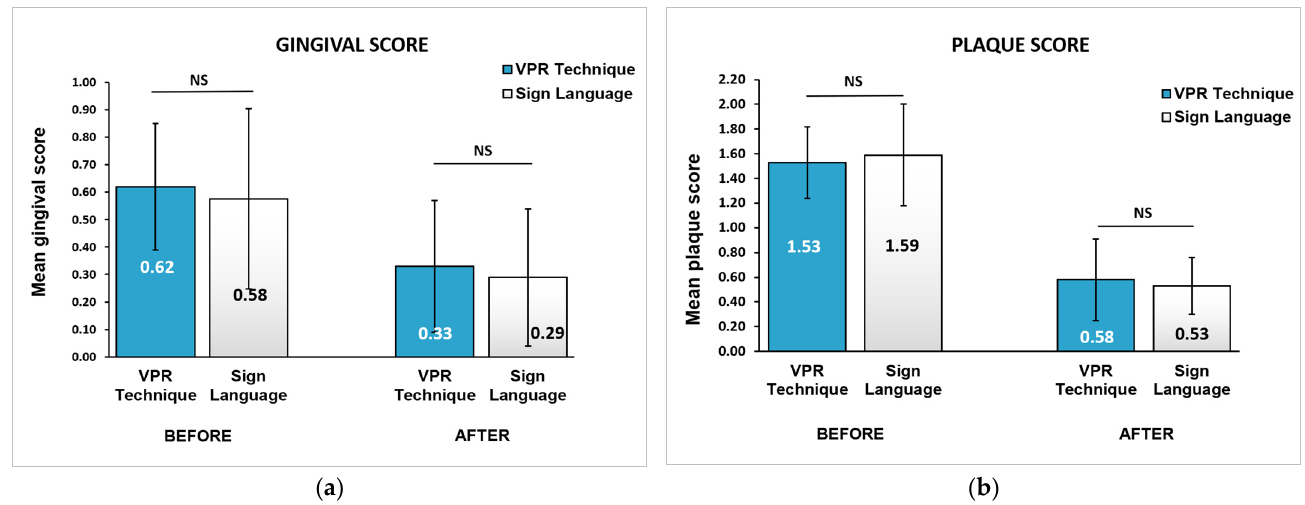
Figure 2. Comparison of ( a ) mean gingival score and ( b ) mean plaque score in the VPR technique group and the sign language group. All values are expressed as mean ± standard deviation. The statistical test used: unpaired t ‐ test; Statistical significance was set at p ≤ 0.05 ; NS: not significant.